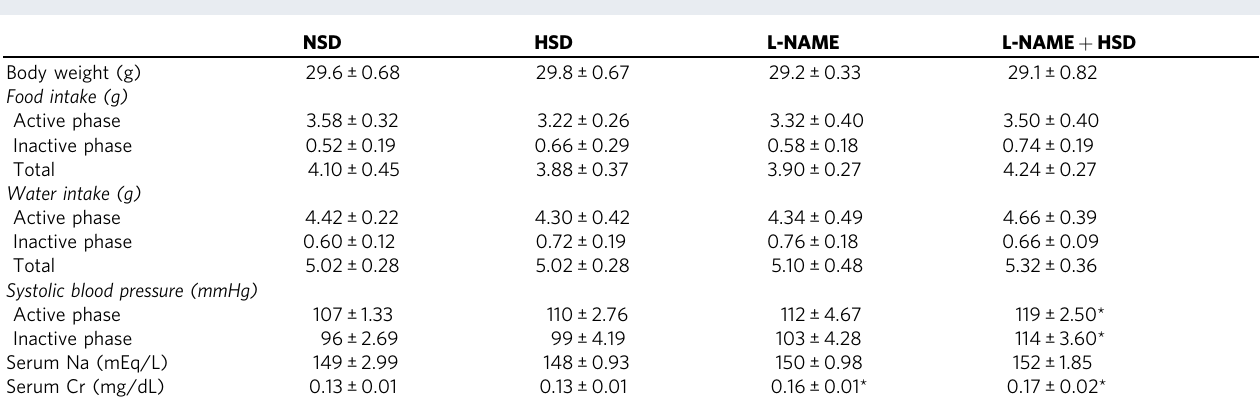
Table 1 Physiological data of the four groups.